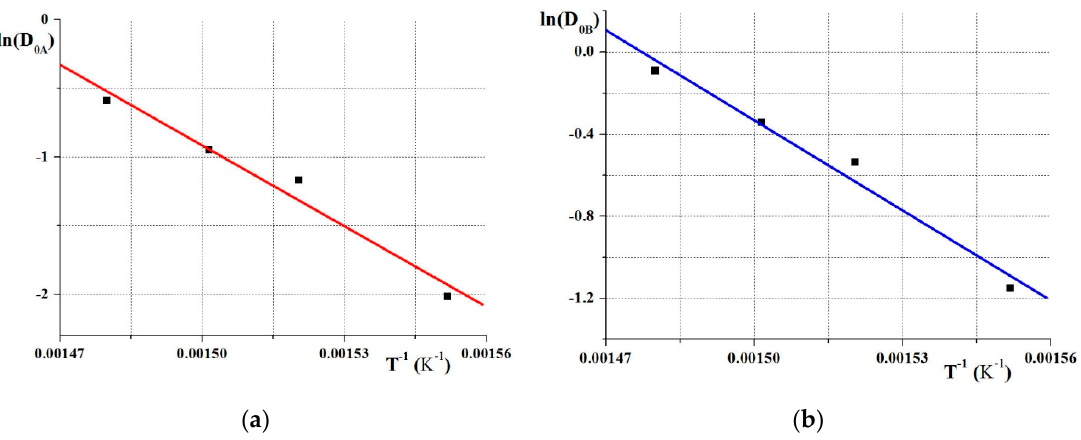
Figure 5. The temperature dependencies of diffusion coefficients (according to the linearized form of the Arrhenius equation) for K + ↔ Na + ion exchange in BK7 glass. ( a ) D 0 A (K + ions), ( b ) D 0 B (Na + ions).